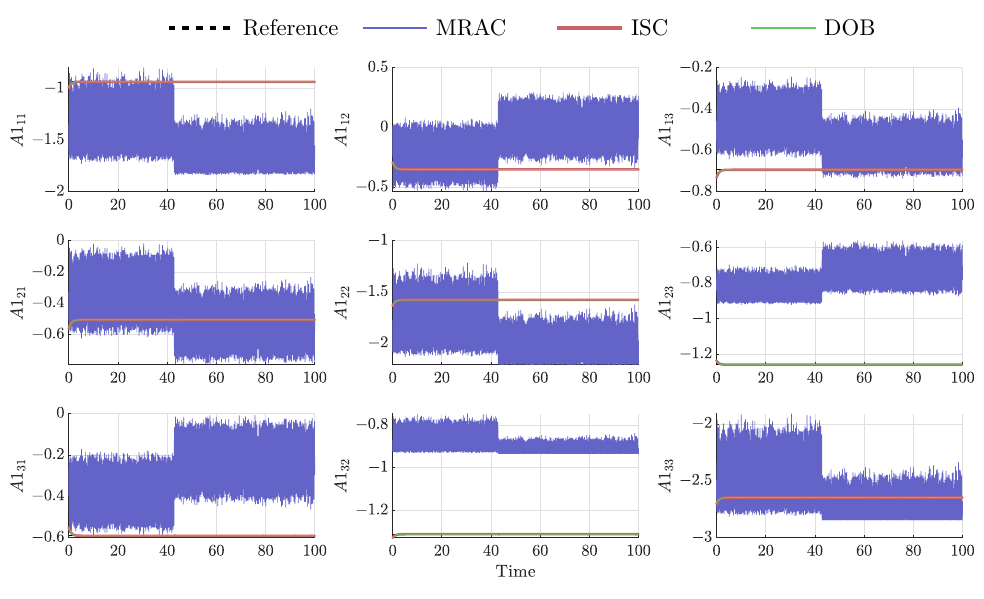
Figure 9. Gains evolution of agent